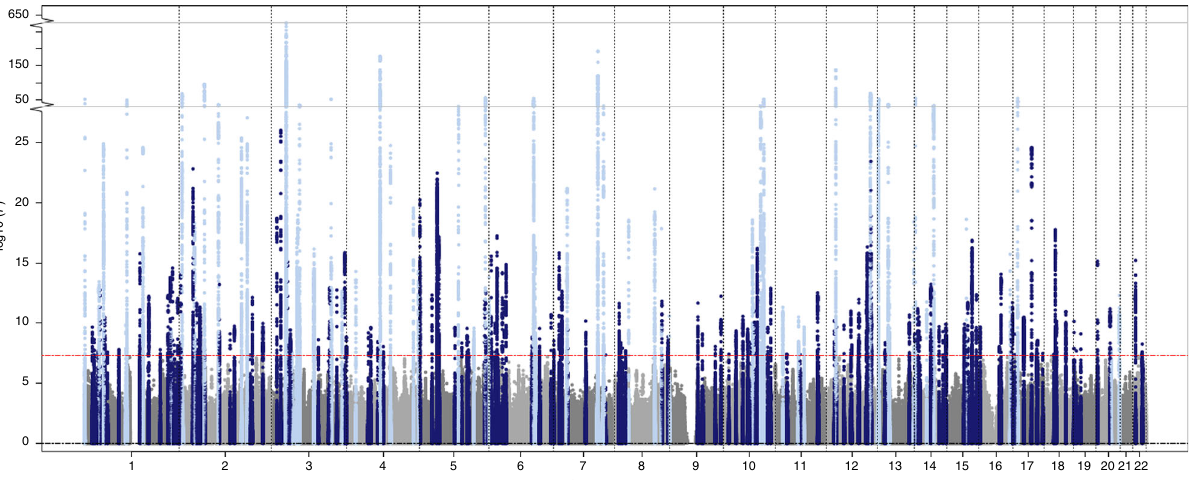
Fig. 2 Manhattan plot of the multi-ancestry meta-analysis for PR interval. P values are plotted on the -log 10 scale for all variants present in at least 60% of the maximum sample size from the fi xed-effects meta-analysis of 293,051 individuals from multiple ancestries (multi-ancestry meta-analysis). Associations of genome-wide signi fi cant ( P < 5 × 10 − 8 ) variants at previously not reported ( N = 141) and previously reported loci ( N = 61) are plotted in dark and light blue colors